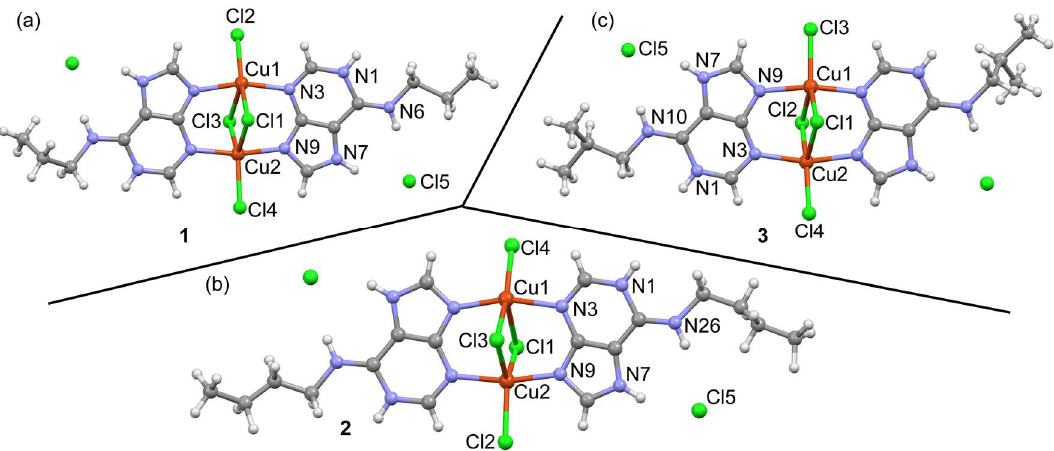
Figure 1. X-ray structure of complexes 1 (a), 2 (b) and 3 (c), with indication of the atom numbering scheme. For compounds 1 and 3 , the alkyl chains present disorder and only one position is given.